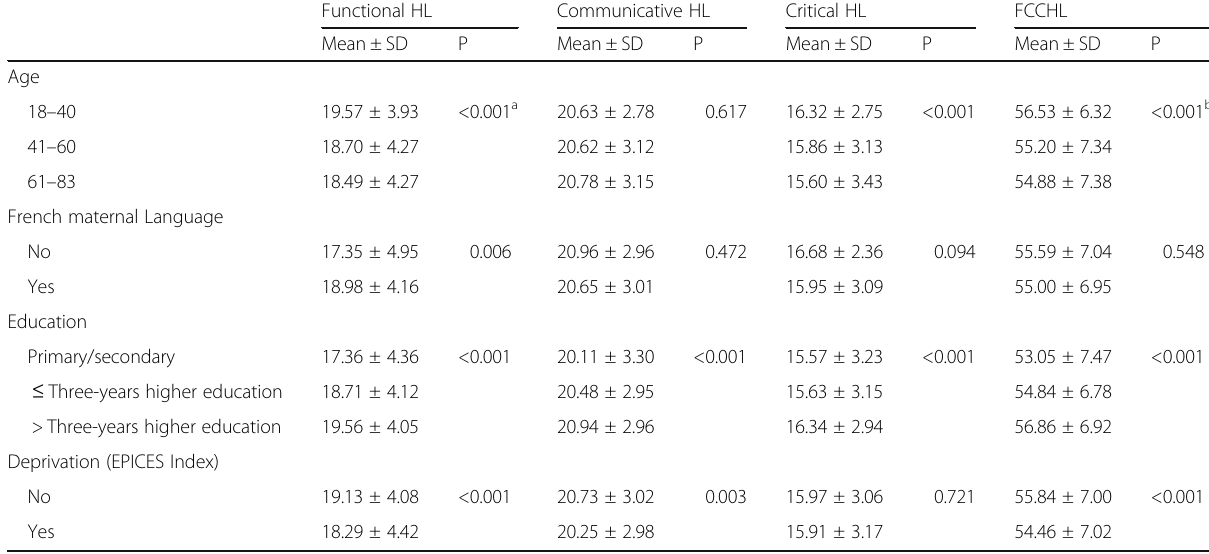
Table 3 Bivariate relationships between FCCHL and sociodemographic characteristics ( n =